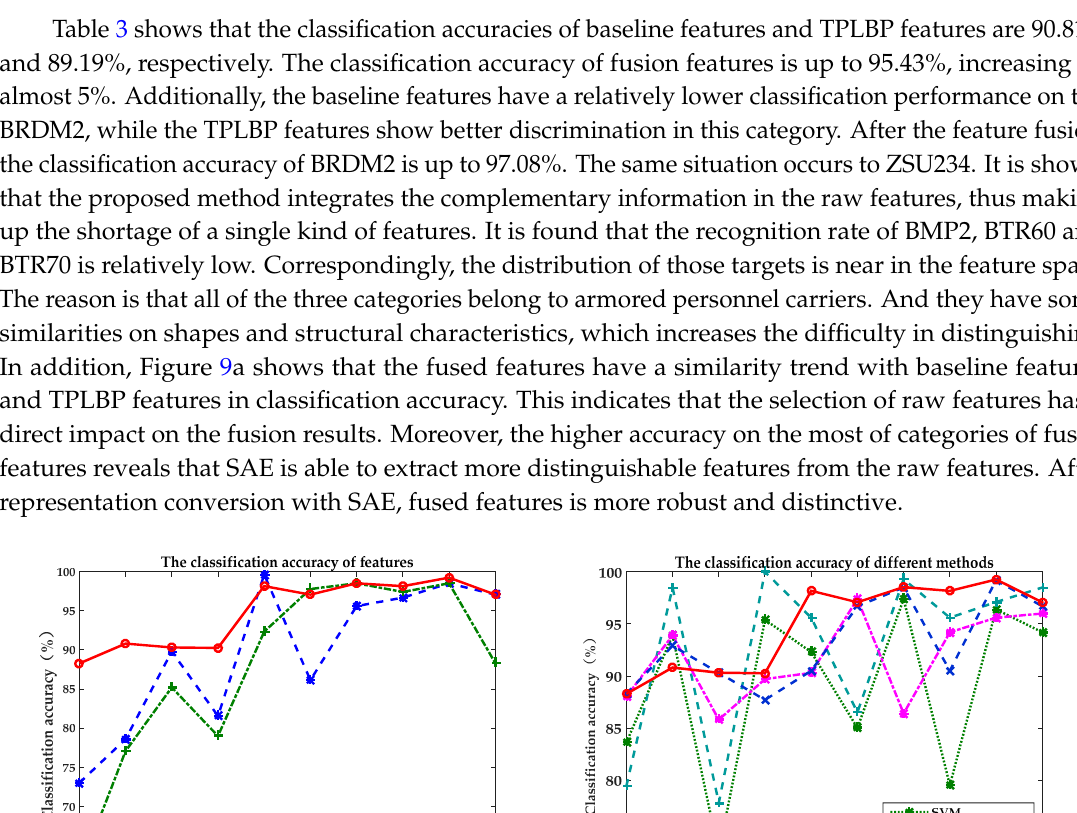
Table 4. The classification accuracy of different features.